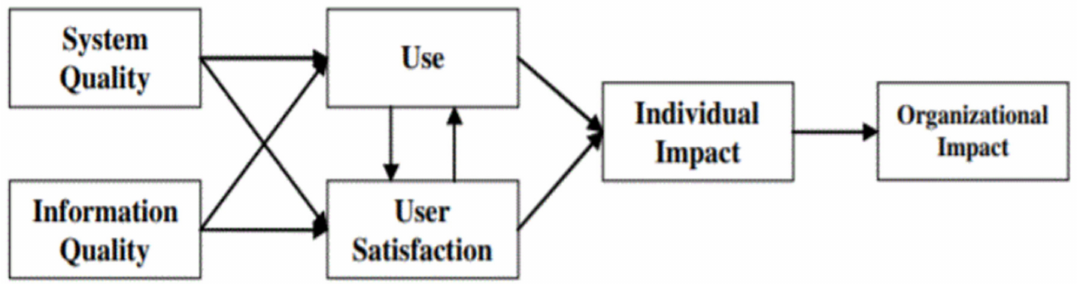
Figure 1. Information system success model (ISS).